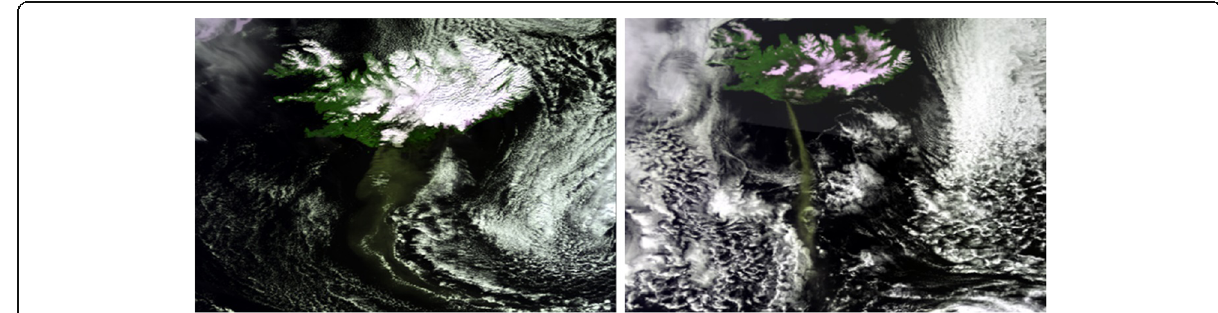
Fig. 8 MODIS preprocessing image (the left is the April 19, 2010, image, and the right is the May 11, 2010, image)